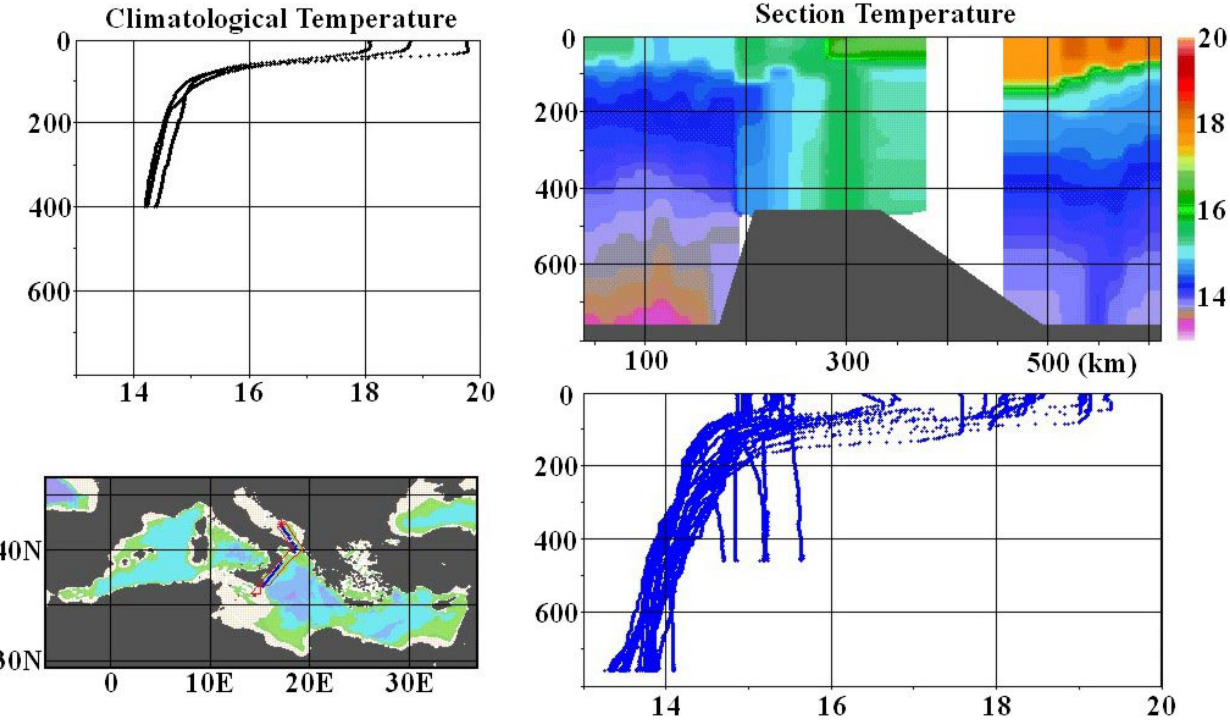
Fig. 10. Last step of the NRT.QC.XBT procedures with visual check and comparison with climatology. The visual control of the profiles of the same track is shown on the right panels and a comparison with climatology is given in the upper left